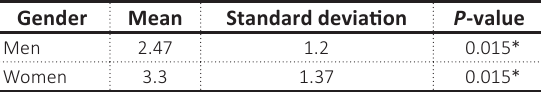
Table 7. Career advancement and job satisfaction